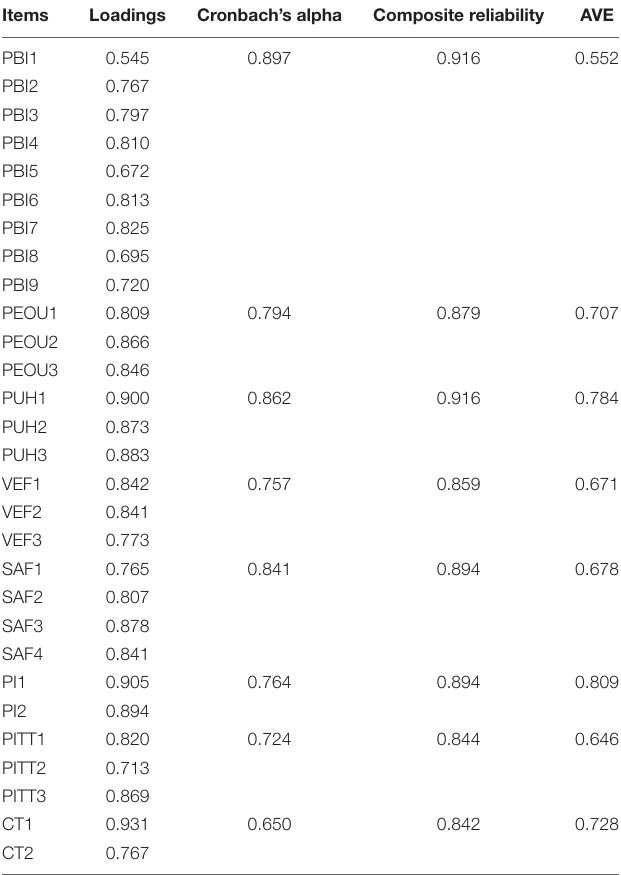
TABLE 2 | Loadings, reliability, and convergent